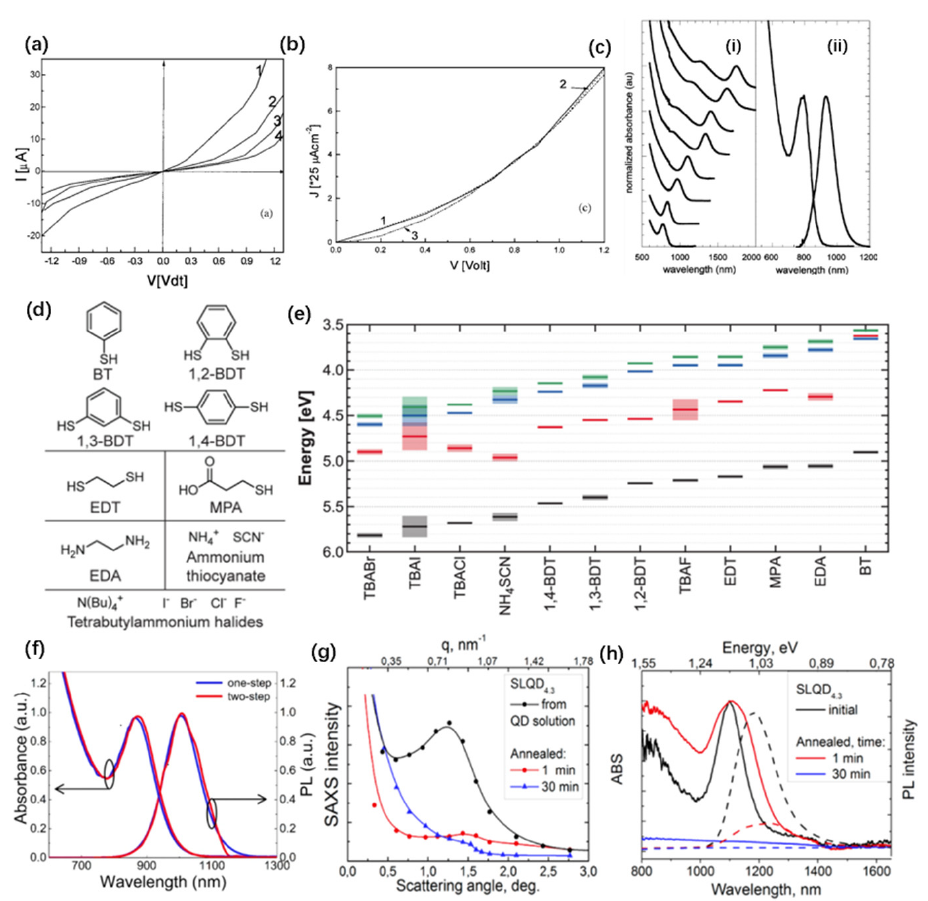
Figure 2. ( a ) I-V characteristics of PbS NCs measured with different NCs mole %. Reprinted with permission from Ref. [38]. Copyright 2002 Springer Nature. ( b ) I-V characteristic of PbS NCs measured at various temperatures. Reprinted with permission from Ref. [38]. Copyright 2002 Springer Nature. ( c ) (i) Absorption spectra of PbS CQDs with different sizes. (ii) Typical absorption (left curve) and fluorescence (right curve) spectra of PbS QDs. Reprinted with permission from Ref. [33]. Copyright 2006 American Chemical Society. ( d ) Chemical structures of the ligands studied by Patrick. Reprinted with permission from Ref. [35]. Copyright 2014 American Chemical Society. ( e ) Energy level